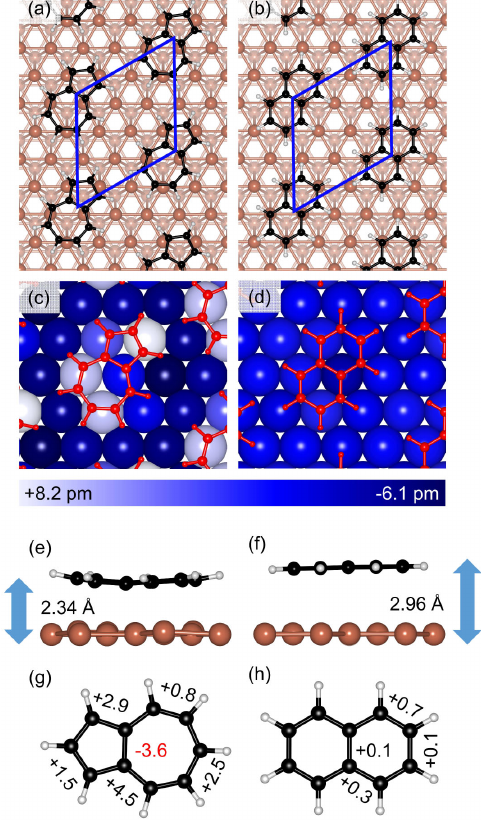
FIG. 8. Structural data for azulene and naphthalene on Cu(111) from dispersion-corrected DFT-D3 calculations. (a,b) Top view ffiffiffi p ffiffiffi p 3 3 Þ -R30° structure. The most favor- of the optimized ð 2 × 2 able adsorption site for both molecules is hcp-hcp. (c,d) Vertical displacements (in pm) of the copper atoms in the topmost layer, compared to the relaxed surface without a molecule. Positive values mean a displacement towards the molecule. (e,f) Side view ffiffiffi p ffiffiffi p 3 3 Þ -R30° structure. of the molecule in the optimized ð 2 × 2 Azulene shows a large distortion and is much closer to the surface than naphthalene (average adsorption height 2.34 Å vs 2.96 Å). (g,h) Changes of the in-plane bond lengths relative to the gas phase structure (in